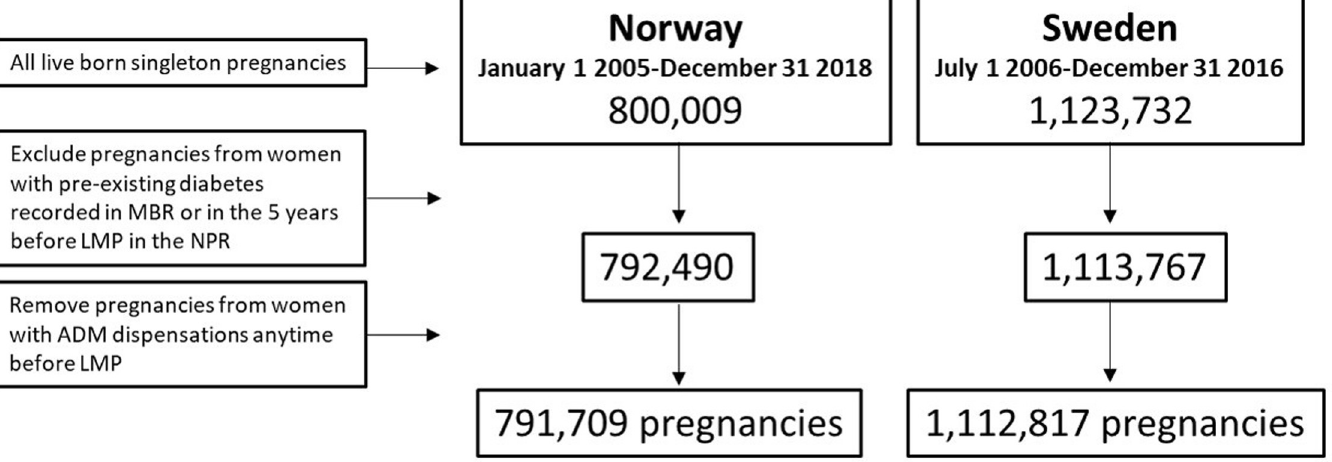
Fig 1. Flowchart illustrating the derivation of the study